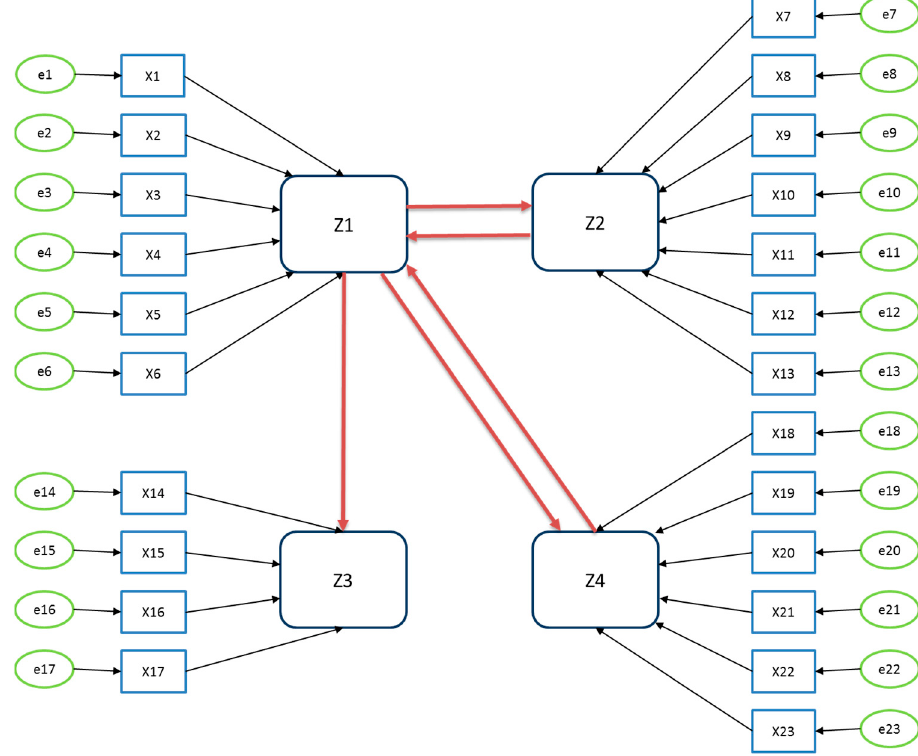
Figure 4. Estimated structural model. Source: Own study based on survey results.